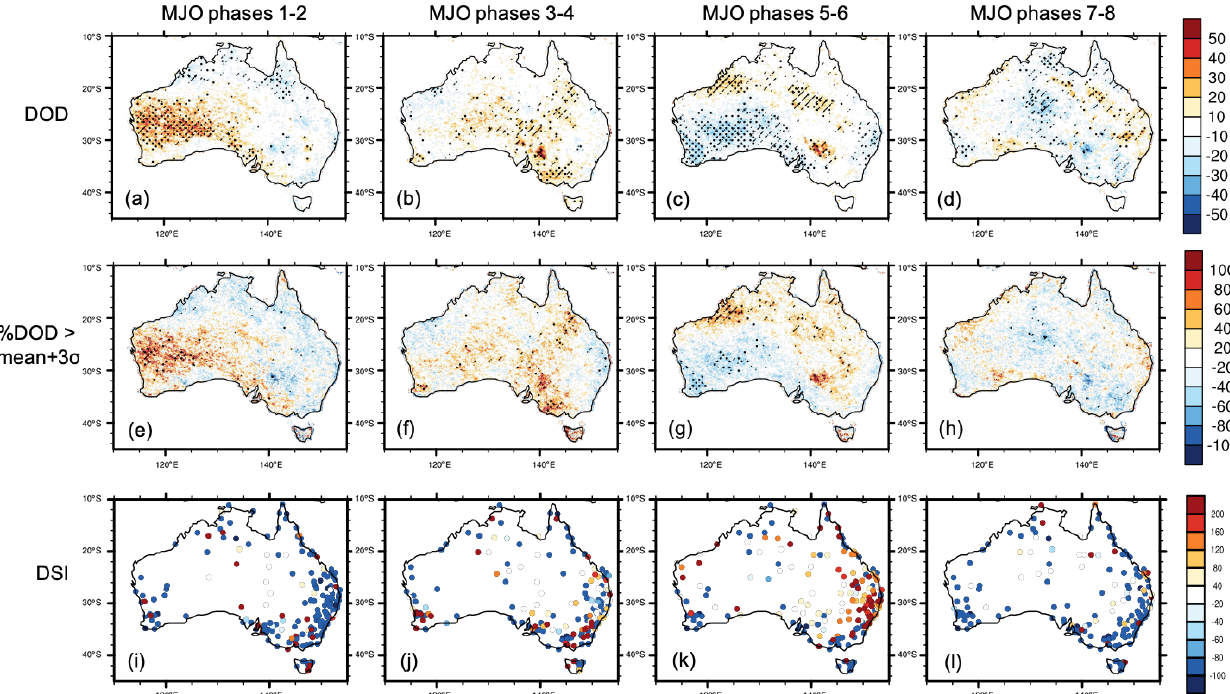
Figure 11. Mean anomalies (% climatology) in dust activity by MJO phase in September–February. Analyzed dust variables include (a–d) DOD averaged from MODIS-Terra and MODIS-Aqua, (e–h) frequency of daily DOD anomaly exceeding 3 times the interannual standard deviation, and (i–l) DSI. The anomalies for each consecutive two MJO phases, namely phases 1–2, 3–4, 5–6, and 7–8, are calculated as the percentage differences between these two phases and the long-term average during September–February of 2003–2019. The composites consist of 376, 492, 613, and 450d with RMM > 1 for phases 1–2, 3–4, 5–6, 7–8, respectively. In (a–h) , the stitches indicate regions with significant percentage difference with the climatology ( p < 0 . 05), based on a Monte Carlo bootstrap test, and the slashes further denote regions with significant positive correlation between MODIS DOD and MISR nsAOD. In (i–l) , only statistically significant percentage differences ( p < 0 . 05) are shown.